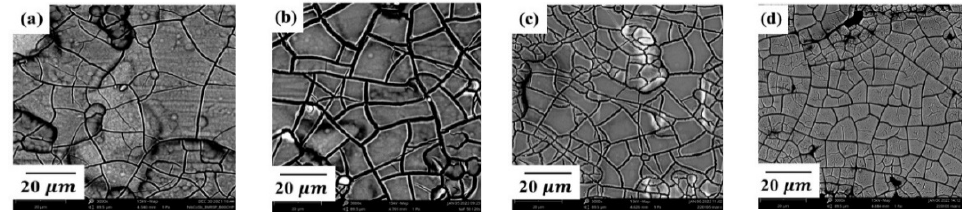
Figure 7. The 120 s chromium conversion treatment, 3000 diameter SEM surface images of Zn–Ni flakes at different NaF concentrations: ( a ) NaF 0%, ( b ) NaF 50%, ( c ) NaF 100%, and ( d ) NaF 150%.